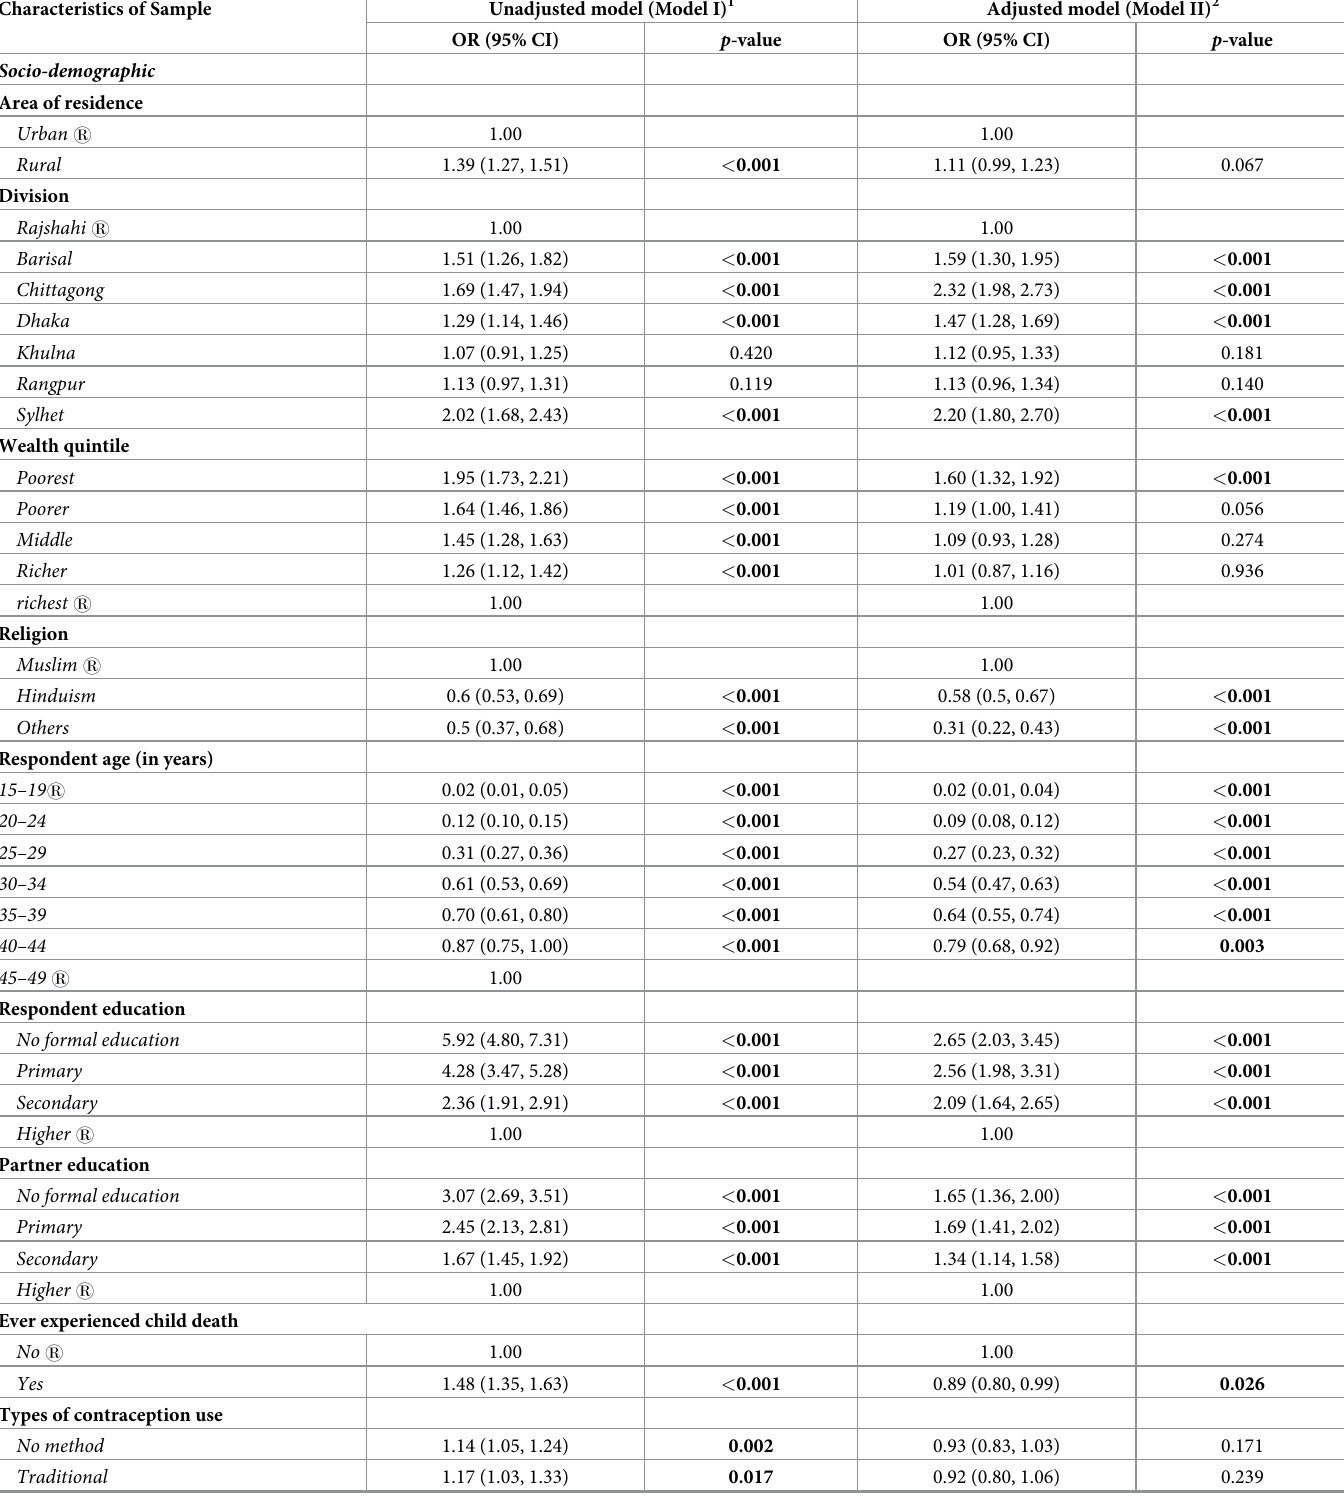
Table 3. Logistic regression analysis of associated factors for unmet fertility desires among women by socio-demographic and empowerment characteristics. Characteristics of